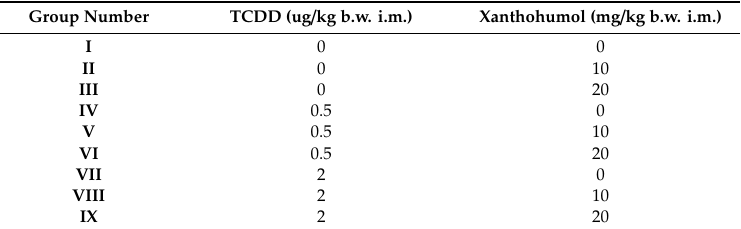
Table 1. Scheme of the animal groups formed for the experiment. The animals were divided into nine groups, including a negative control group. 2,3,7,8-tetrachlorodibenzo- p -dioxin (TCDD) and Xanthohumol (XN) were administered intramuscularly to birds in di ff erent doses. Group Number TCDD (ug / kg b.w. i.m.) Xanthohumol (mg / kg b.w.